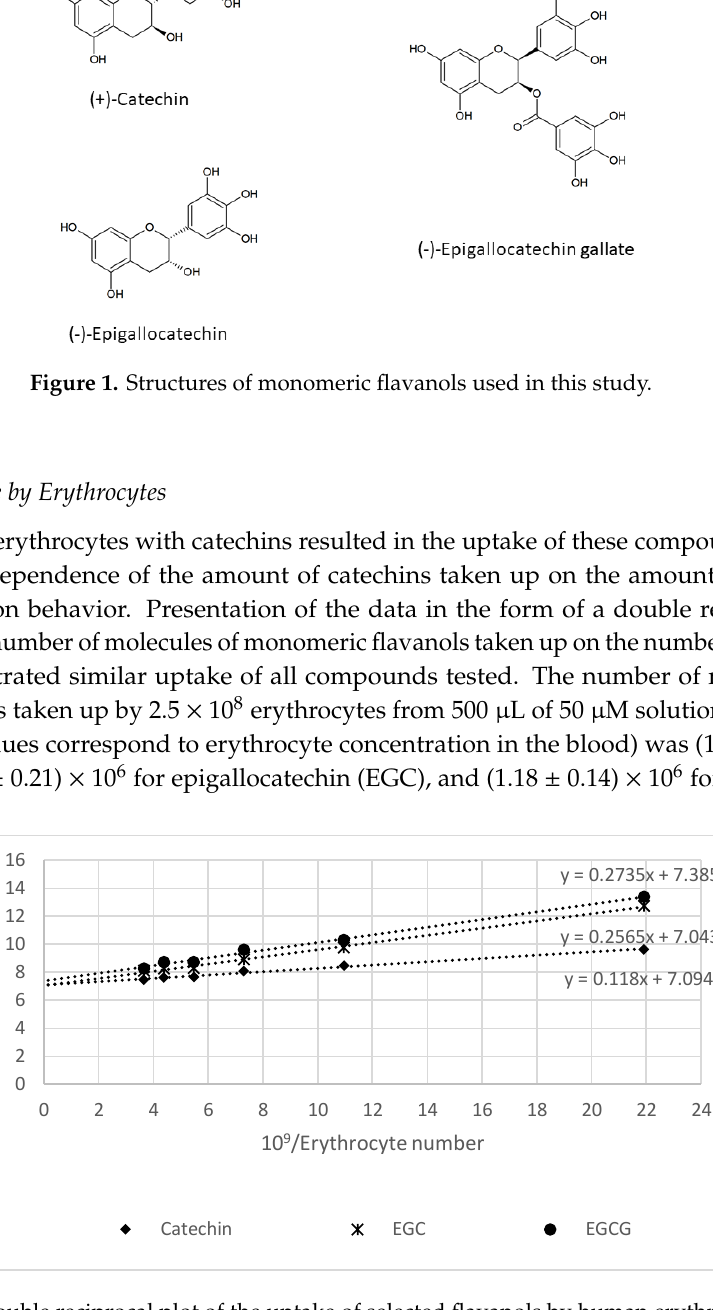
Figure 2. The double reciprocal plot of the uptake of selected flavanols by human erythrocytes. EGC, epigallocatechin; EGCG, epigallocatechin gallate.